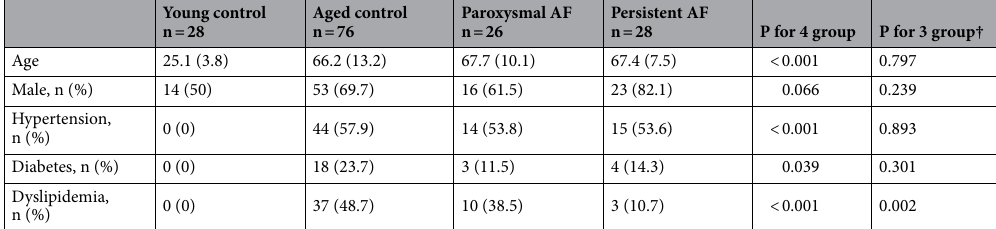
Table 1. Baseline characteristics of study subjects. Data were shown as numbers (%) (Male, Hypertension, Diabetes, and Dyslipidemia), mean (standard deviation) (Age). AF refers to atrial fibrillation. † Comparison among aged control, paroxysmal AF and persistent